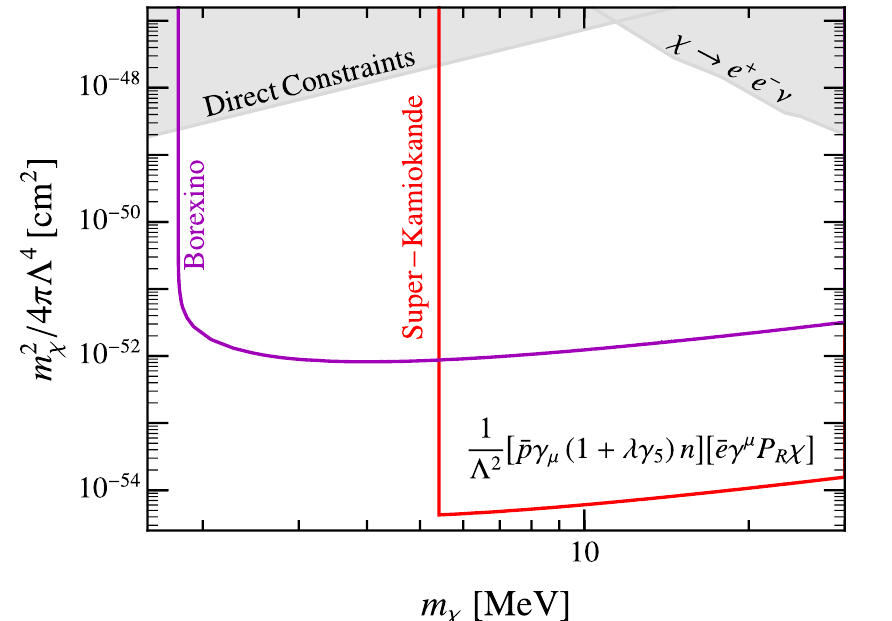
Figure 7 . The projected constraints from a dedicated search for induced (cid:12) + signals from Hydrogen at Super K and